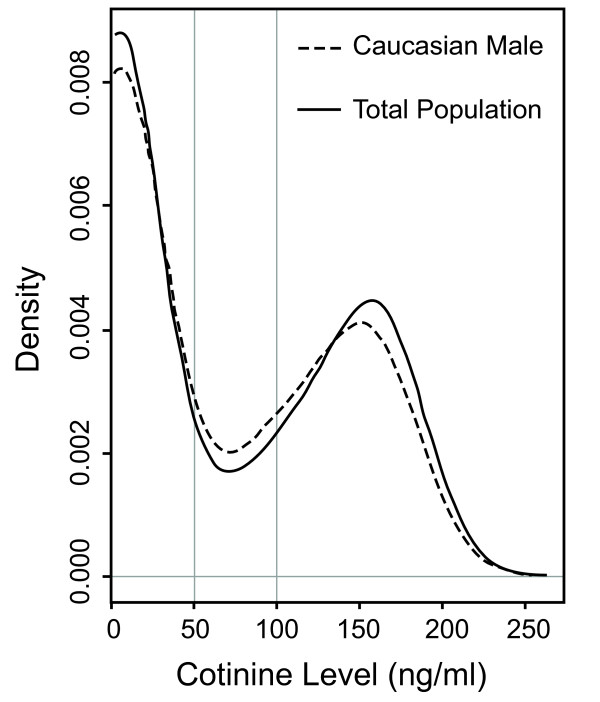
Histogram of plasma cotinine concentration. Distribution of plasma cotinine levels in the total population as well as in the Caucasian male sub-population are demonstrated. Vertical lines represent selected cut-offs for definitions of tobacco users and non-users.